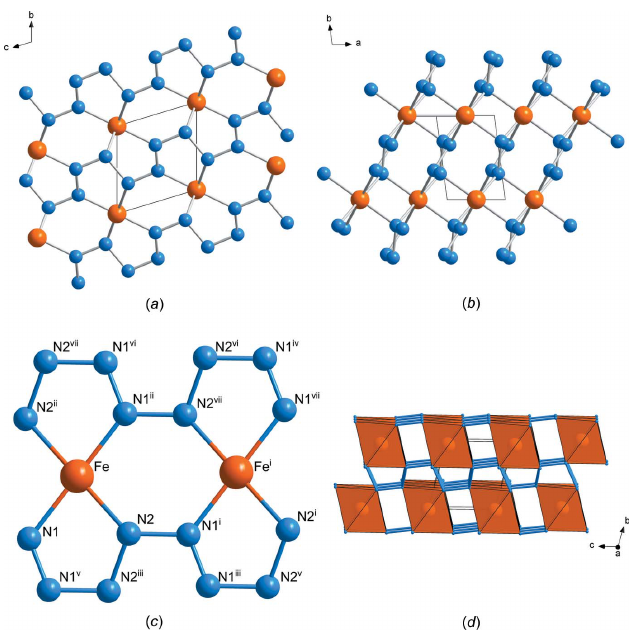
Figure 1 The crystal structure of FeN 4 at 180 GPa. ( a ) and ( b ) Projections of the crystal structure along [100] and [001], respectively. ( c ) A fragment of the crystal structure showing the coordination of Fe atoms. [Symmetry codes: (i) x , y , 1 + z ; (ii) 1 (cid:2) x , (cid:2) y , (cid:2) z ; (iii) (cid:2) x , 1 (cid:2) y , (cid:2) z ; (iv) 1 + x , 1 + y , 2 + z ; (v) (cid:2) x , (cid:2) 1 (cid:2) y , (cid:2) 1 (cid:2) z ; (vi) 1 + x , 1 + y , 1 + z ; (vii) 1 (cid:2) x , (cid:2) y , 1 (cid:2) z ; (viii) 1 + x , 1 + y , z .] ( d ) The crystal structure of FeN 4 in polyhedral